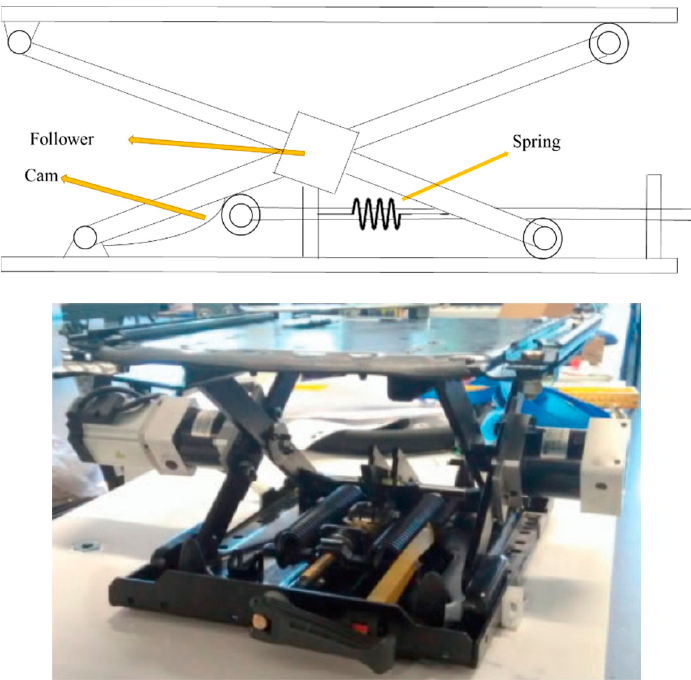
Figure 15. Active seat suspension configuration.